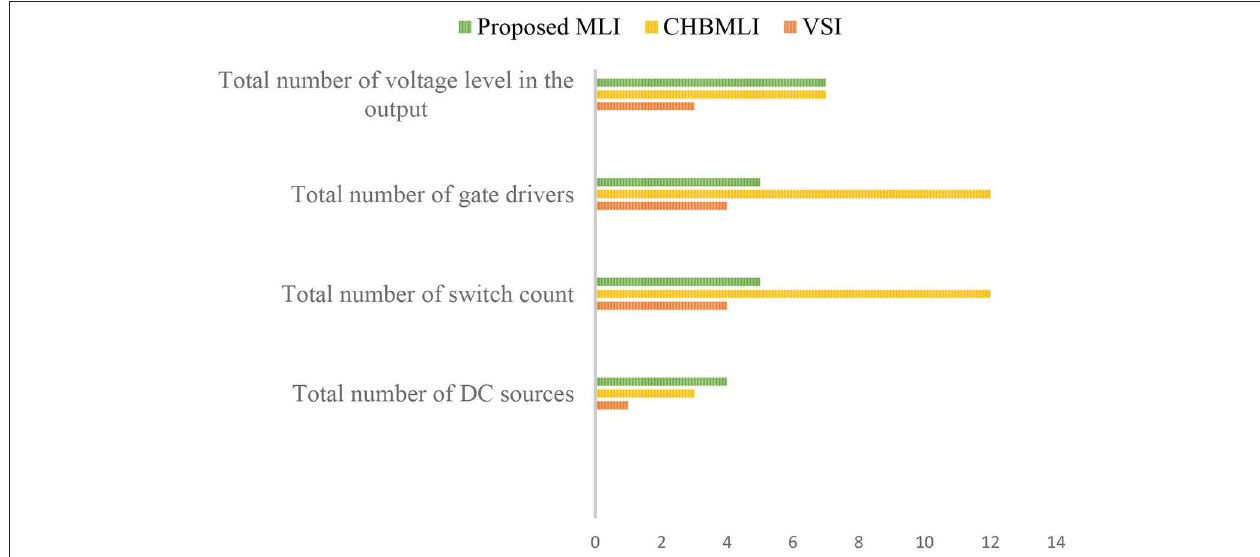
FIGURE 10 | Comparison of part count in proposed multilevel inverter (MLI) and others.